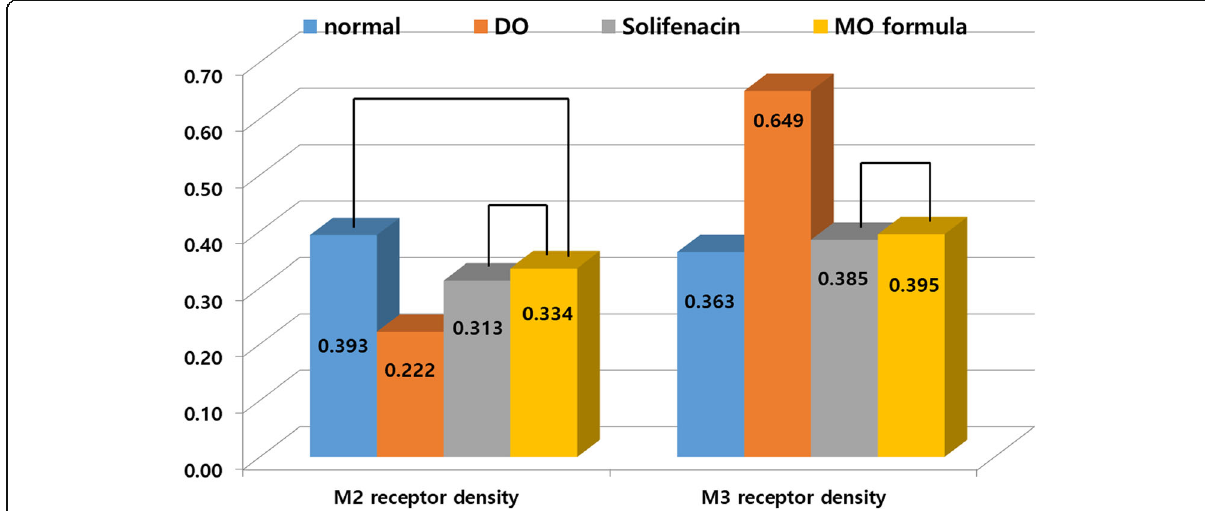
Fig. 3 Expression of muscarinic receptor density. The DO group showed the lowest M2 receptor density and the highest M3 recpetor density, showing statistically significant differences. However, there was no significant difference between solifenacin and MO formula group